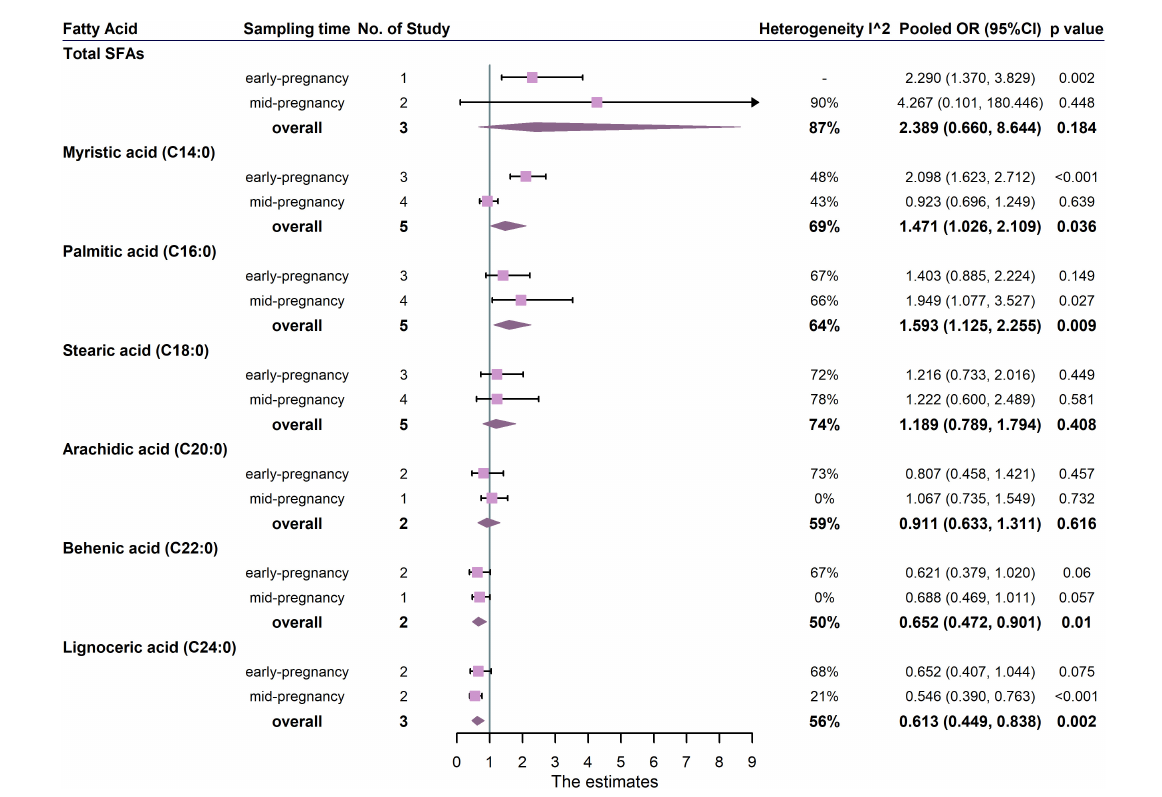
p = 0.0013) had publication bias, but sensitivity analysis